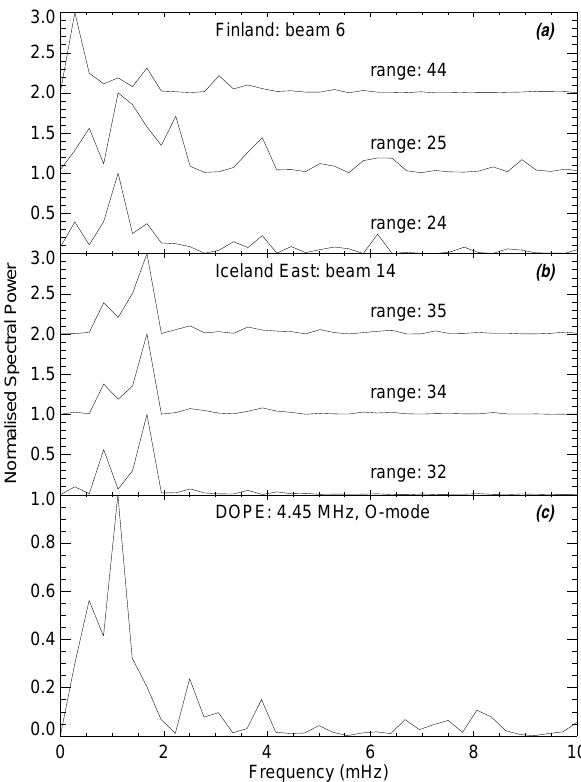
Fig. 6a. Magnetometer H -component data from the IMAGE and SAMNET arrays, 23 February 1996. Time series records for 09:00– 13:00UT. Vertical dotted lines indicate approximate arrival times at the ionosphere of events labelled “A” to “E” in Figs. 2 and